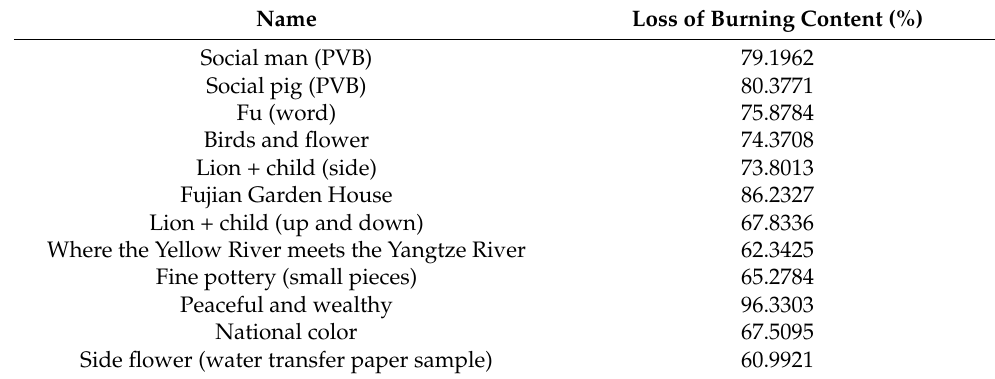
Table 3. The loss of paper consumption as a percentage of the mass of paper indifferent papers at 850 ◦ C.